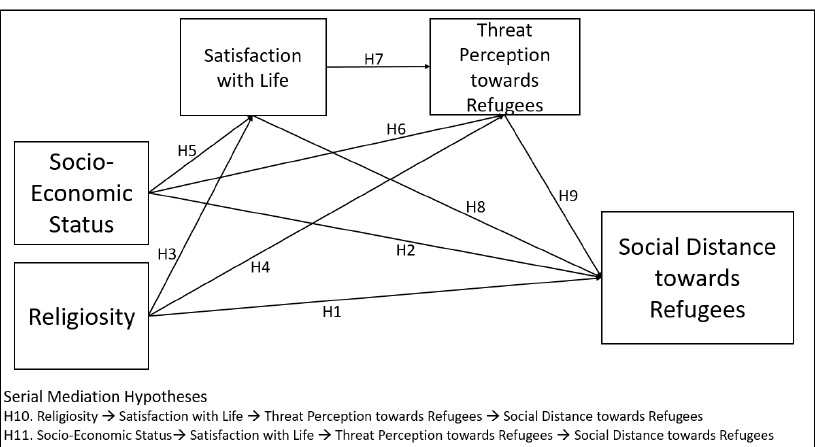
Figure 1. Research conceptual model.